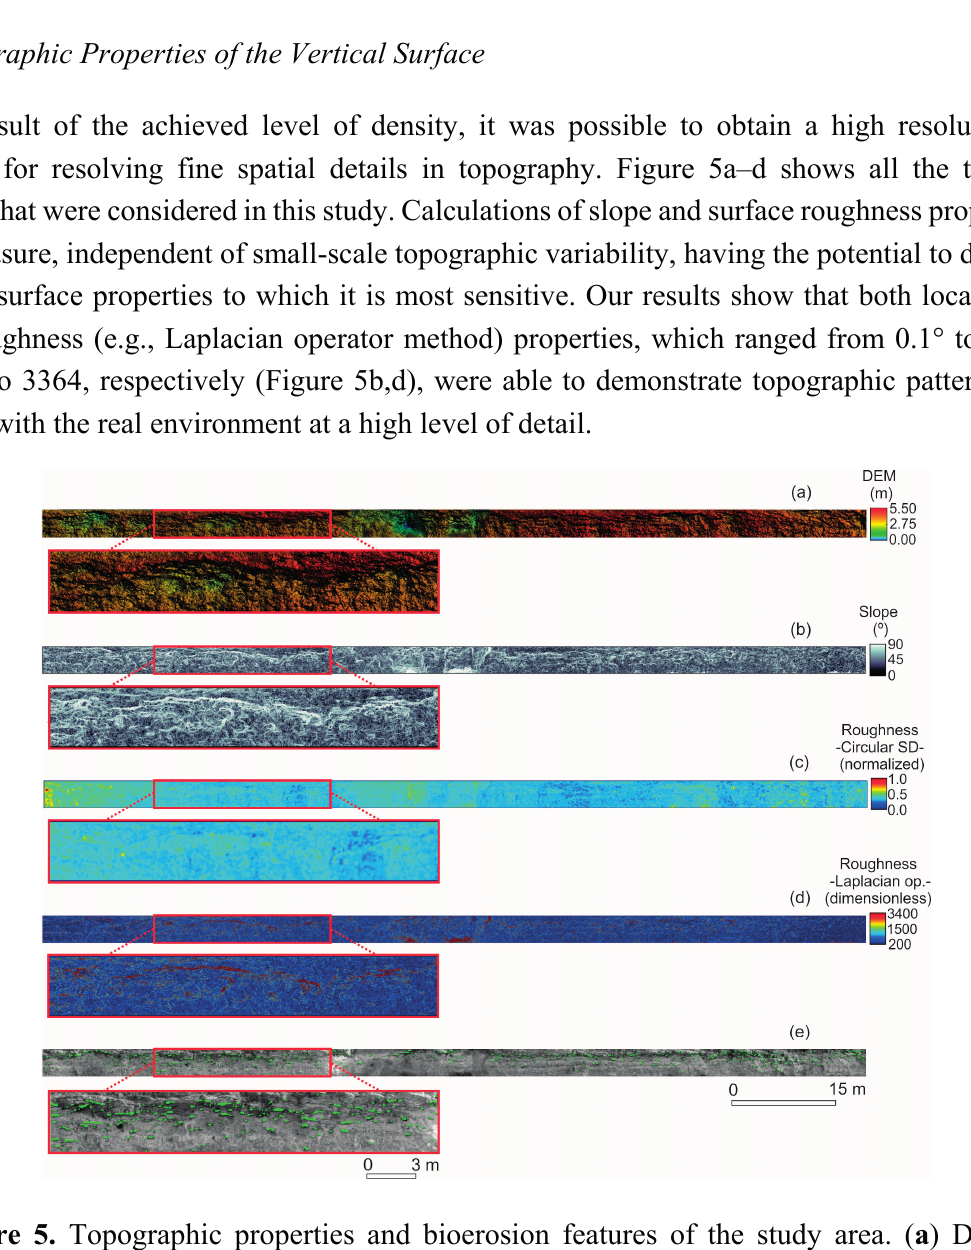
Figure 5. Topographic properties and bioerosion features of the study area. ( a ) Digital elevation model (DEM); ( b ) Slope angle; ( c ) Surface roughness based on circular standard deviation; ( d ) Surface roughness based on Laplacian operator. ( e ) Bioerosion features (green polygons) superimposed over the dense point cloud. Note: The DEM was created by using triangulation with linear interpolation gridding method (spacing = 0.02